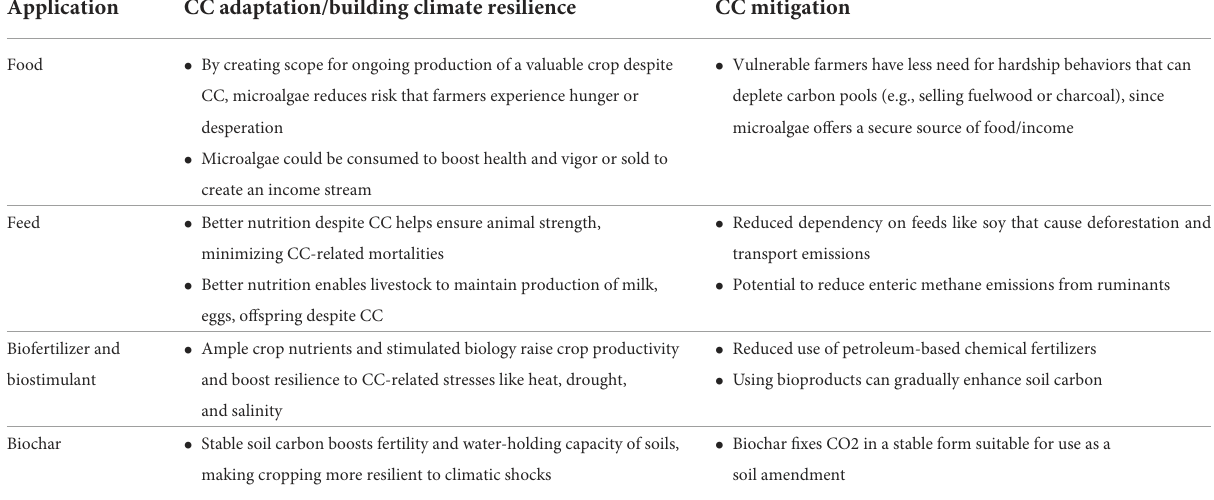
TABLE 7 Possible ways agri-food applications of microalgae could serve as climate actions.